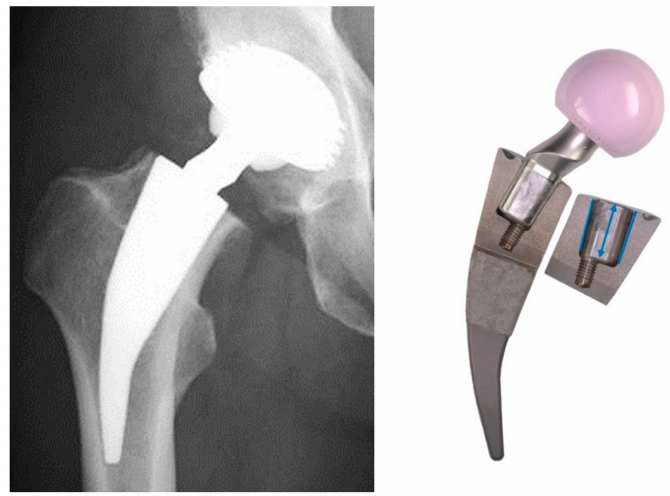
Figure 1. Modular Ti alloy short hip stem with a dual taper CoCr neck—Metha ® modular.